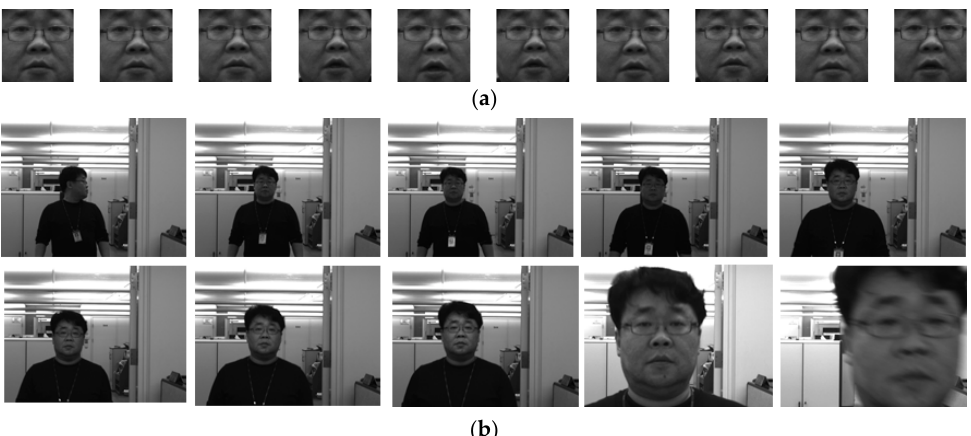
Figure 10. Examples of face databases for experiments: ( a ) examples in the E-face database; ( b ) examples in the XM2VTS face database; and ( c ) examples in the PF07 database with frontal face pose, neutral face expression, and 16 illumination variations.